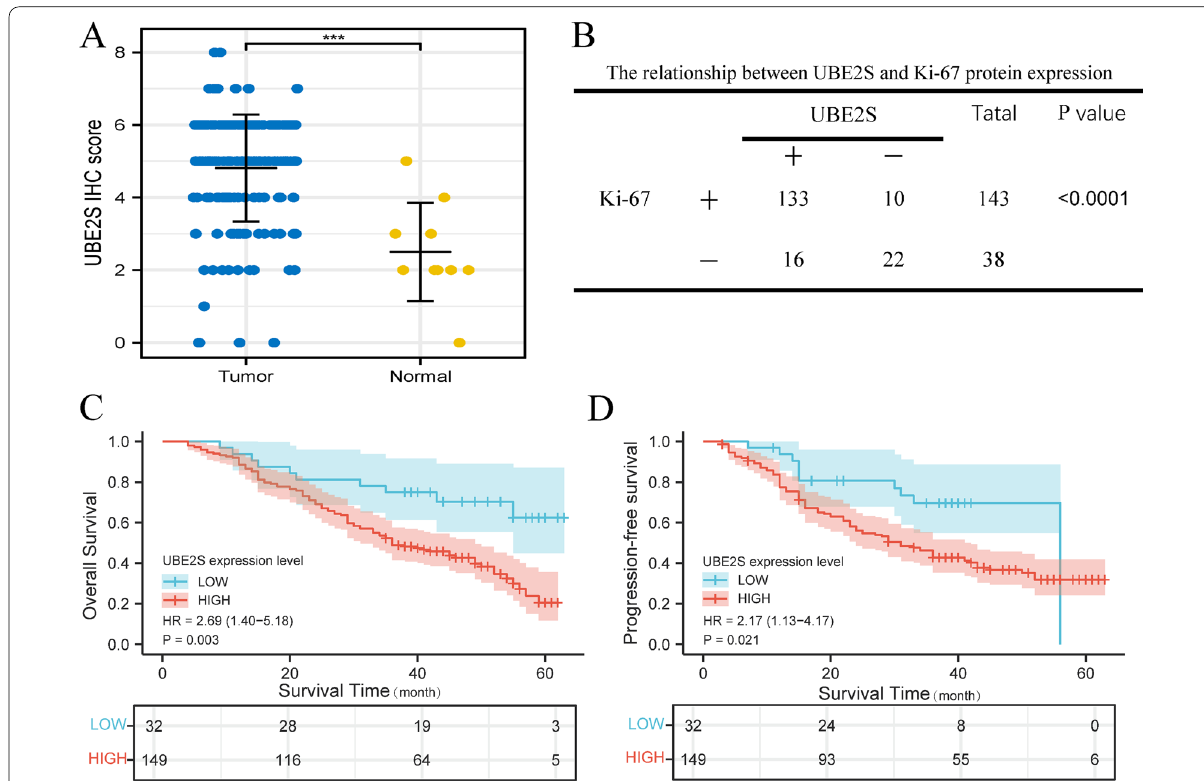
Fig. 5 Expression differences in UBE2S protein expression levels, Ki67 correlation and prognostic significance in OV patients. A Immunostaining scoring of UBE2S protein in ovarian cancer and normal ovarian tissue. B Statistical table of the correlation distribution of UBE2S protein and Ki67 expression in ovarian cancer tissue. C The relationship between UBE2S expression levels with OS in OV patients. D The relationship between UBE2S expression levels with PFS in OV patients. According to the results of IHC staining, OV patients were assigned to the UBE2S high expression group or UBE2S low expression group. Kaplan–Meier survival analysis was then carried out